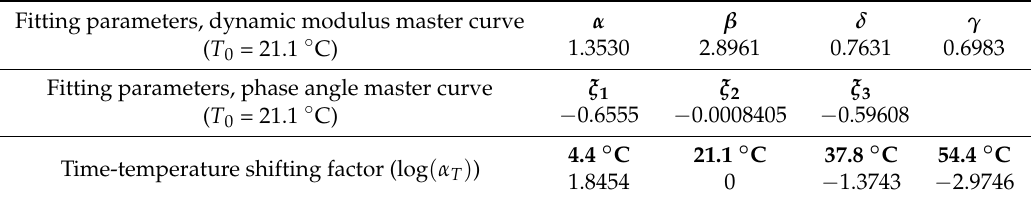
Table 2. Summary of fitting parameters for the Hot Mix Asphalt